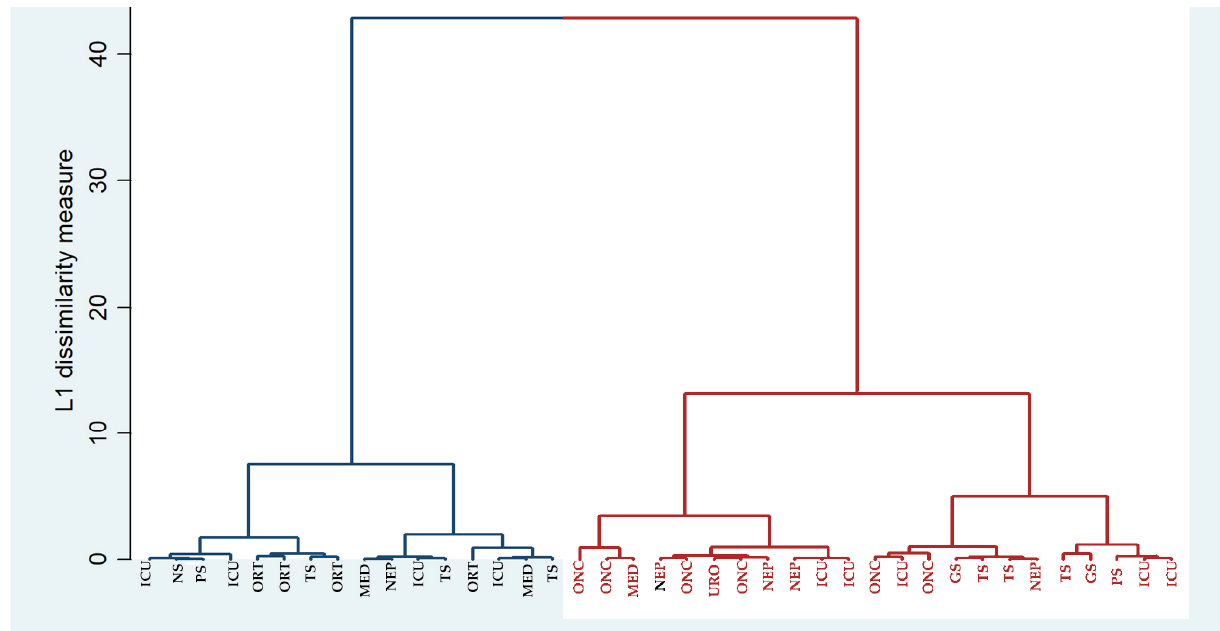
Figure 7. Clustering analys1is of the isolated Klebsiella strain using hospital ward as a label. ICU: Intensive Care Unit; NS: Neurosurgery; PS: Plastic Surgery; ORT: Orthopaedics; TS: Thoracic Surgery; MED: Medical wards; NEP: Nephrology; ONC: Oncology; URO: Urology; GS: General Surgery. Blue lines: low resistance cluster, red lines: high resistance cluster.